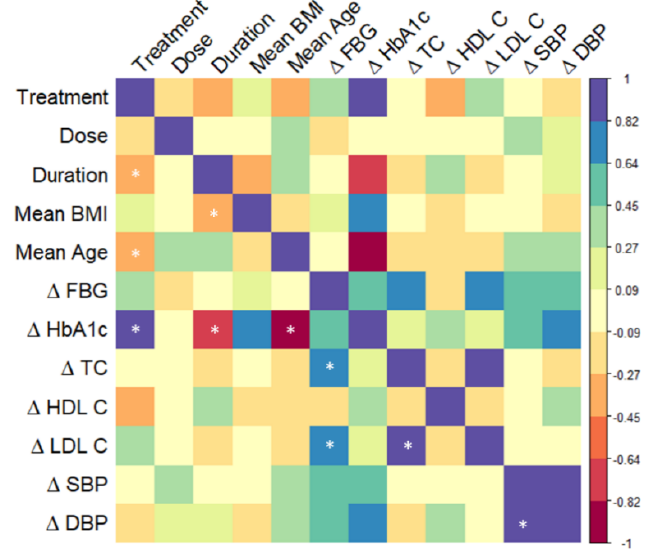
Figure 3. Correlation heatmap of study characteristics, subject characteristics and percentage change in fasting blood glucose, HbA1c, cholesterols and blood pressure levels across 24 studies. The treatments were expressed as numbers (bilberry and blackcurrant = 1, grape seed = 2). Mean BMI and age were calculated for each study population where reported. FBG—fasting blood glucose, HbA1c—glycated hemoglobin, TC—total cholesterol, HDL C—high density lipoprotein cholesterol, LDL C—low density lipoprotein cholesterol, SBP—systolic blood pressure, DBP—diastolic blood pressure. The matrix was calculated using corrplot [19] in R studio. * p < 0.01. When considering significant correlations ( p ≤ 0.01) across studies, we observed that average changes in HbA1c levels were positively correlated with treatment (R = 0.84; p = 0.008), indicating that bilberry and blackcurrant extract (treatment 1) may be more effec- tive than grape seed extract (treatment 2) in lowering HbA1c levels. In addition, average changes in HbA1c were negatively correlated with age (R = −0.88; p = 0.003), and with study duration (R = −0.69; p = 0.005), indicating that larger reductions in HbA1c levels were observed in subjects who were older and participating in longer-term studies. Aver- age changes in levels of fasting blood glucose were positively correlated with average changes in total cholesterol (R = 0.78; p = 0.007) and LDL cholesterol levels (R = 0.7; p = 0.002), suggesting that modulation of these outcomes could share common mechanistic pathways, such as those involved in increasing insulin sensitivity. Average changes in total and LDL cholesterol were positively correlated (R = 0.87; p < 0.001), as were average changes in systolic and diastolic blood pressure (R = 0.88; p < 0.001), which is to be ex- pected, as these outcomes are physiologically linked. Furthermore, treatment was nega- tively correlated with study duration (R = −0.45; p = 0.001) and age of subjects (R = −0.41; p = 0.003), indicating differences in study design and study populations between studies with either bilberry and blackcurrant extract or grape seed extract. Study duration was also negatively correlated with average BMI (R = −0.45; p = 0.002), indicating that partici- pants with a lower BMI took part in longer-term interventions. 3.5. Efficacy of Grape Seed or Bilberry and Blackcurrant Extract Supplements to Modulate Glu- coses Metabolism Nine studies—six studies with grape seed extract [21,23,25,31,32,44] and three stud- ies with bilberry and blackcurrant extract [33,41,43]—measured fasting blood glucose lev- els as an outcome. Five studies—three studies with grape seed extract [23,27,44] and two studies with bilberry and blackcurrant extract [41,43]—measured HbA1c as an outcome. None of the studies with grape seed extract observed significant changes in levels of fast- ing blood glucose or HbA1c, which may be linked to the fact that the majority of these